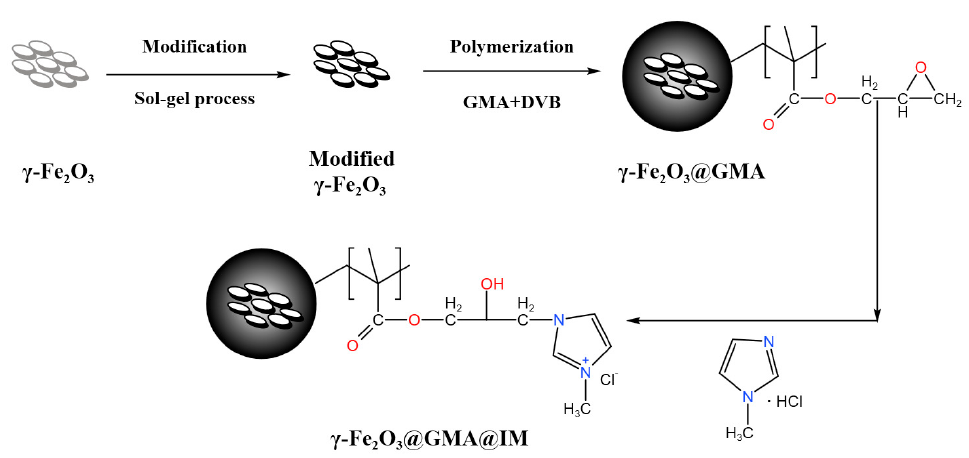
Figure 1. Preparation roadmap of magnetic polymer γ -Fe 2 O 3 @GMA@IM.